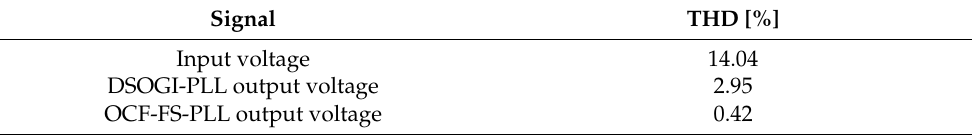
Figure 13. Grid frequency during voltage sag under the presence of the 5th harmonic. Table 2. Filtering performance of the OCF-FS-PLL and DSOGI-PLL under 5th harmonic.